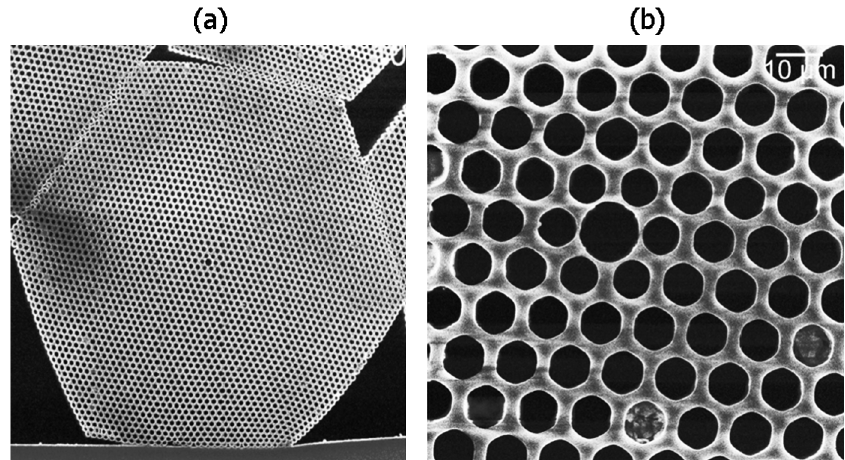
FIG. 8. Photographs showing (a) 700 (cid:3) m -wide cross section of an Incom Inc. capillary fiber drawn from borosilicate glass, and (b) detail of the 12-micron central defect (source: Incom